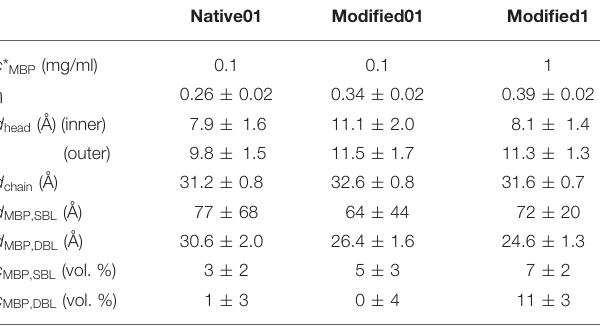
TABLE 2 | Coverage of the second membrane bilayer η , thicknesses of the membrane parts, MBP concentrations in the protein layers, and MBP layer thickness d MBP